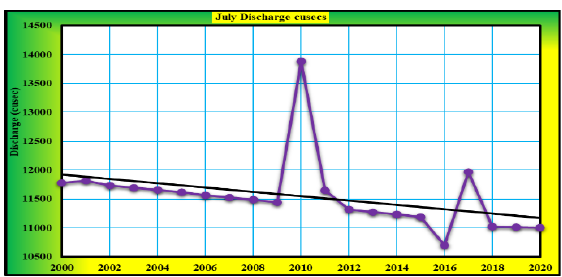
Figure 20: January Month Discharge of Ghotki Feeder Deviation in Ghotki district 2000-2020